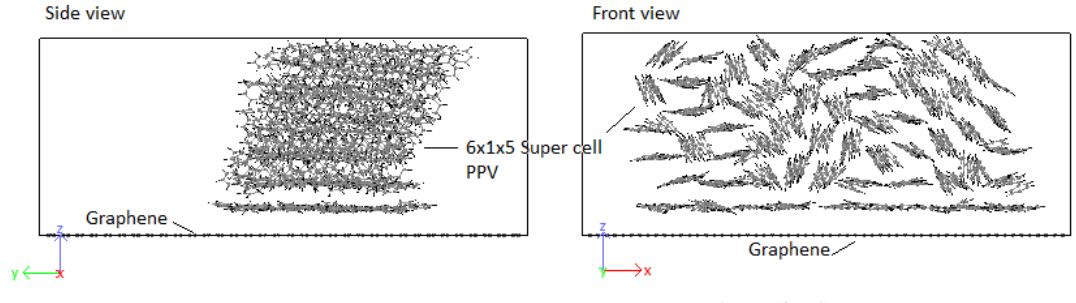
Figure 23. Interaction: 4PPV–7 nm × 7 nm graphene (final).